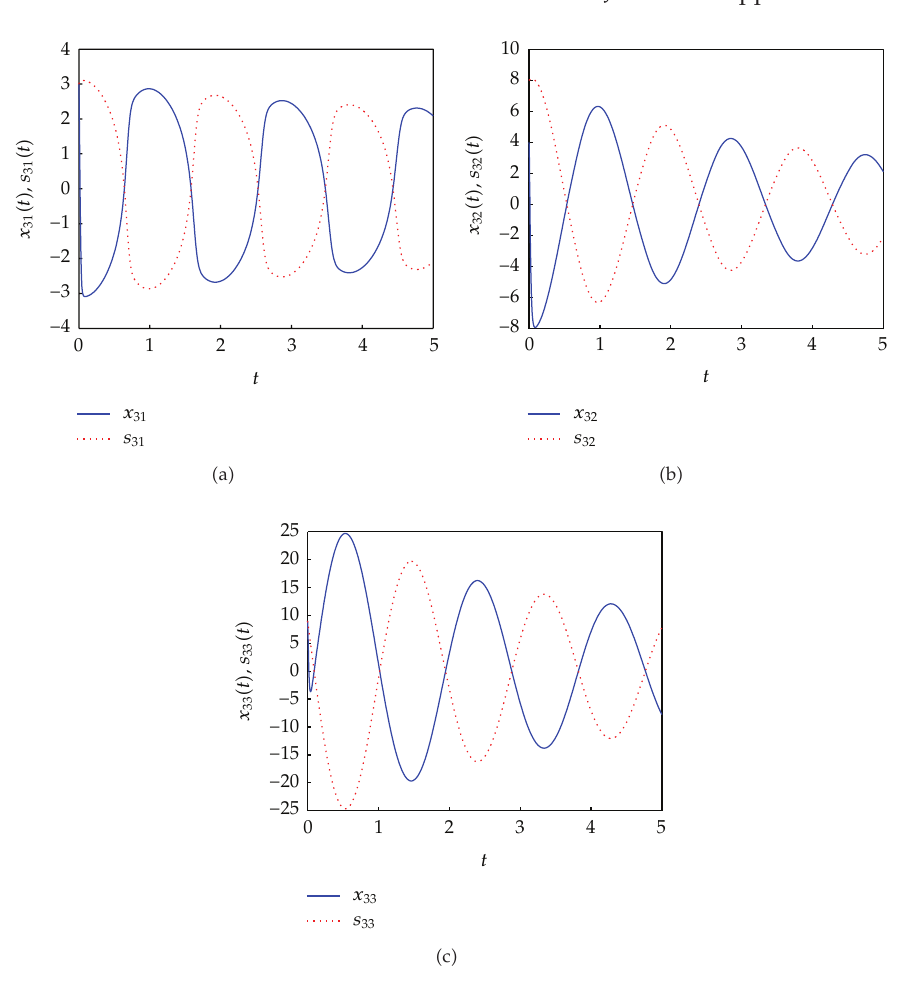
Figure 3: The trajectories of nodes in the third